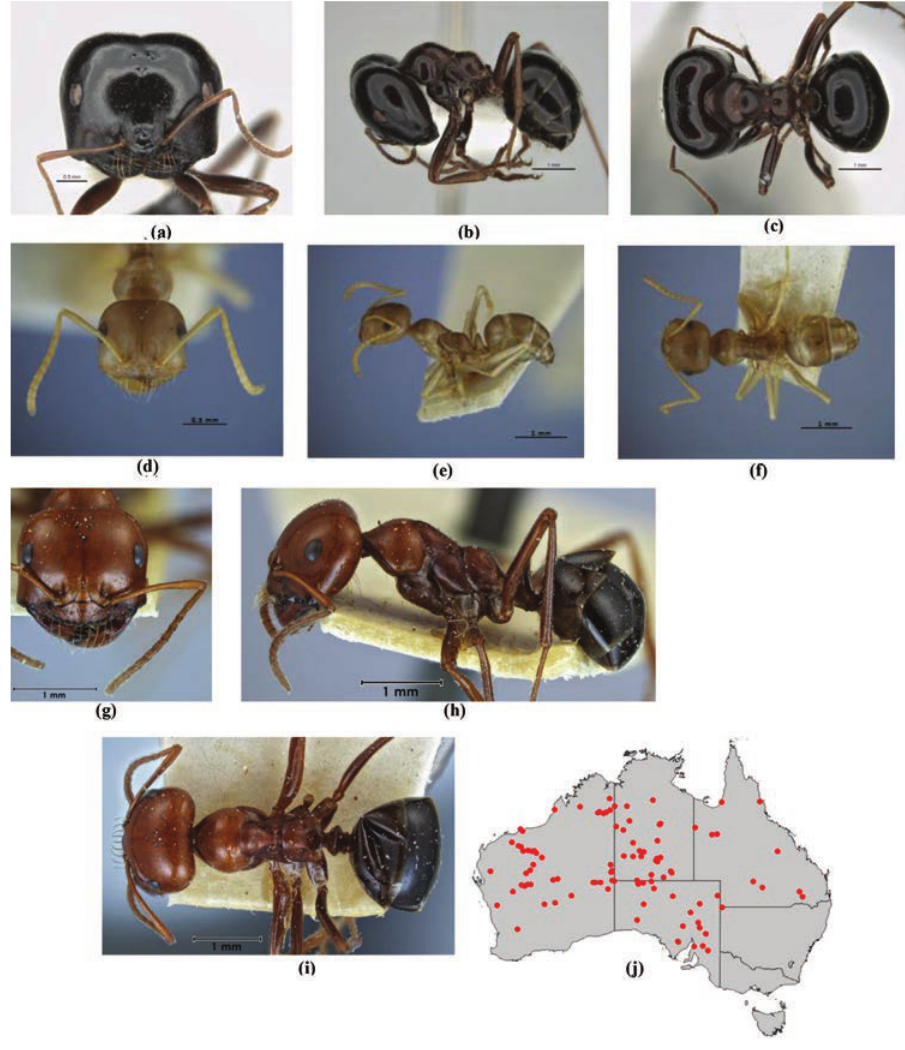
Figure 87. Melophorus wheeleri Forel: ‘ wheeleri ’ non–type major worker (JDM32-9001887) frons ( a ), profile ( b ) and dorsum ( c ); ‘ wheeleri ’ minor worker (MCZ: blanched syntype wrongly ascribed to M . sulla and part of that type series) (MCZC: Cotype 23030 [one of a pin of three ants]) frons ( d ), profile ( e ) and dorsum ( f ); MHNG ‘ omniparens ’ major worker syntype frons ( g ), profile ( h ) and dorsum ( i ); distribution map for the species ( j ). Low resolution scale bars: 1 mm ( b, c ); 0.5 mm ( a ). N Goondiwindi (Dowse, J.E.), 5 mi W Lotus Vale Homestead, N Normanton (Dowse, J.E.), Blair Athol Mine (Houston, W. [ANIC32-040323]), Camooweal Caves, 14 km SSE Camooweal (Shattuck, S.O. [ANIC32-039871]), Mareeba (Hill, H.E.), Tindaree, Hannaford Rd South via Tara (House, A./Brown, S.). South Australia : 1:2500 Gason Ya 636549 (Greenslade, P.J.M.), 15 km ENE Beltana (Greenslade, P.J.M.), 15 km